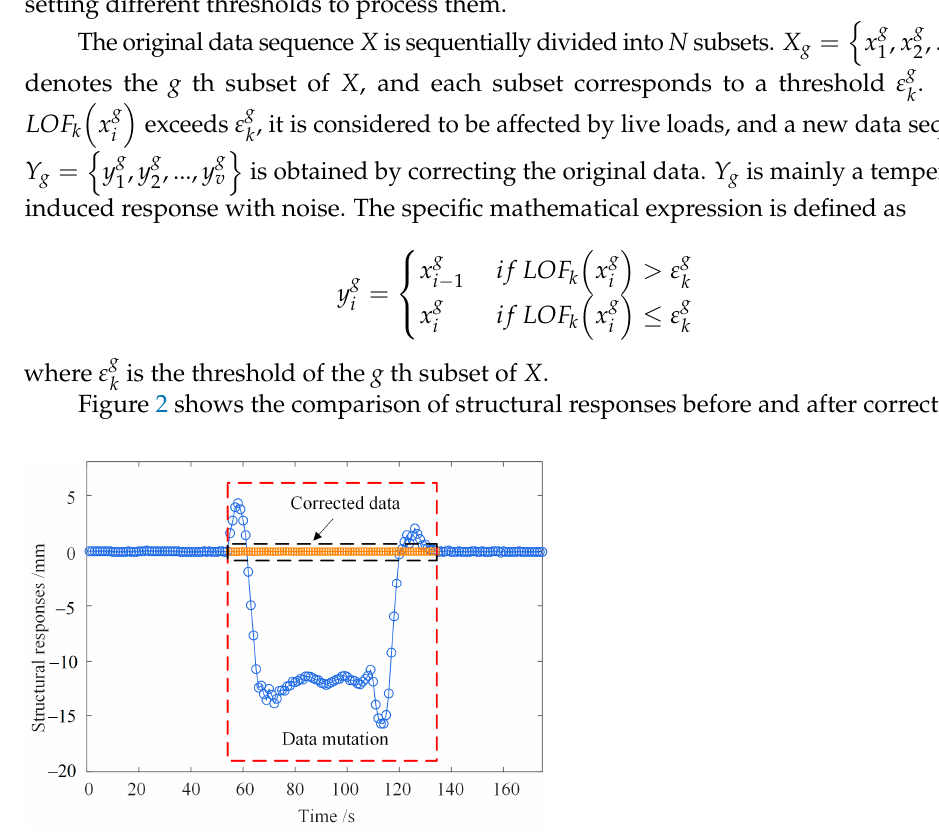
Figure 2. Comparison of structural responses before and after correction.